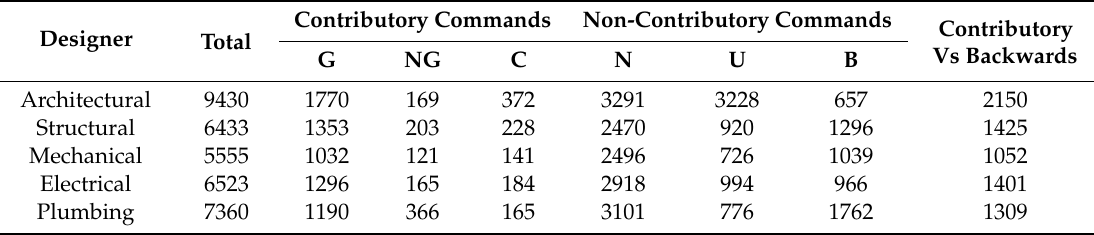
Table 2. Total number of commands executed by each